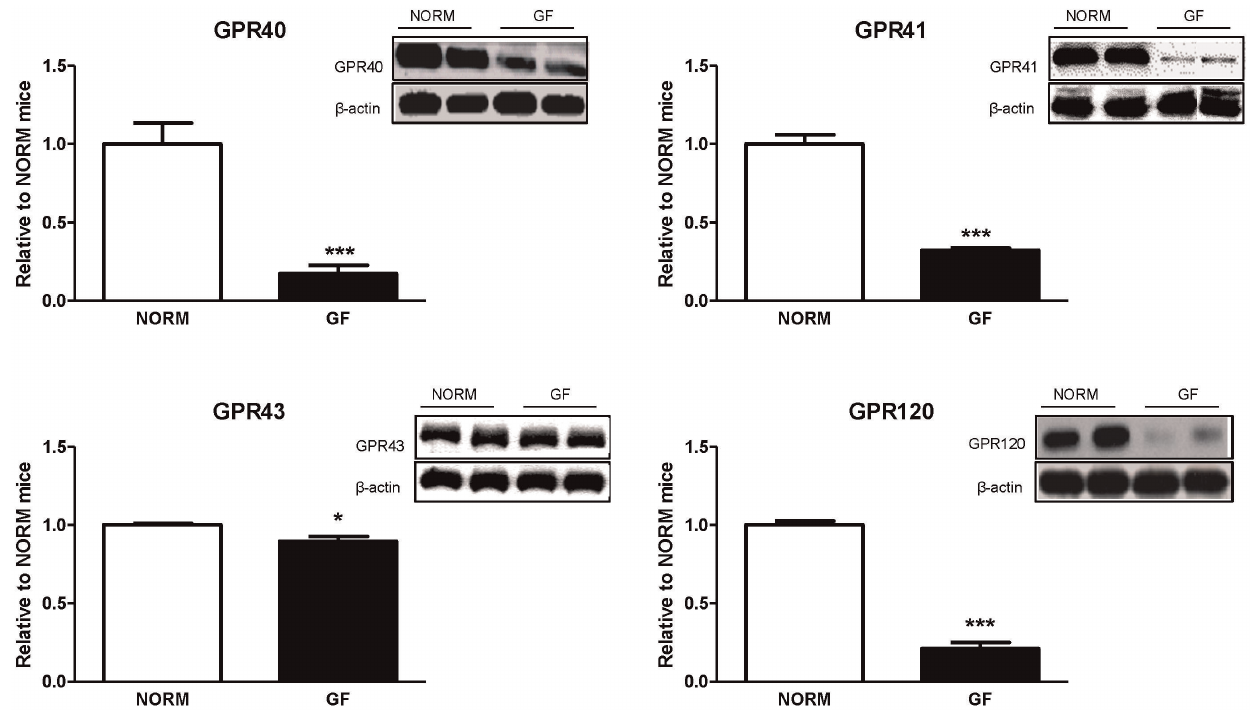
Figure 3. Intestinal epithelial protein expression of fatty-acid responsive receptors in GF and NORM mice. GF mice displayed down- regulation of proximal intestinal GPR40, 41, 43, and 120 relative to NORM mice. Data are expressed as means 6 SEM. *P , 0.05, ***P , 0.001, compared to NORM mice.